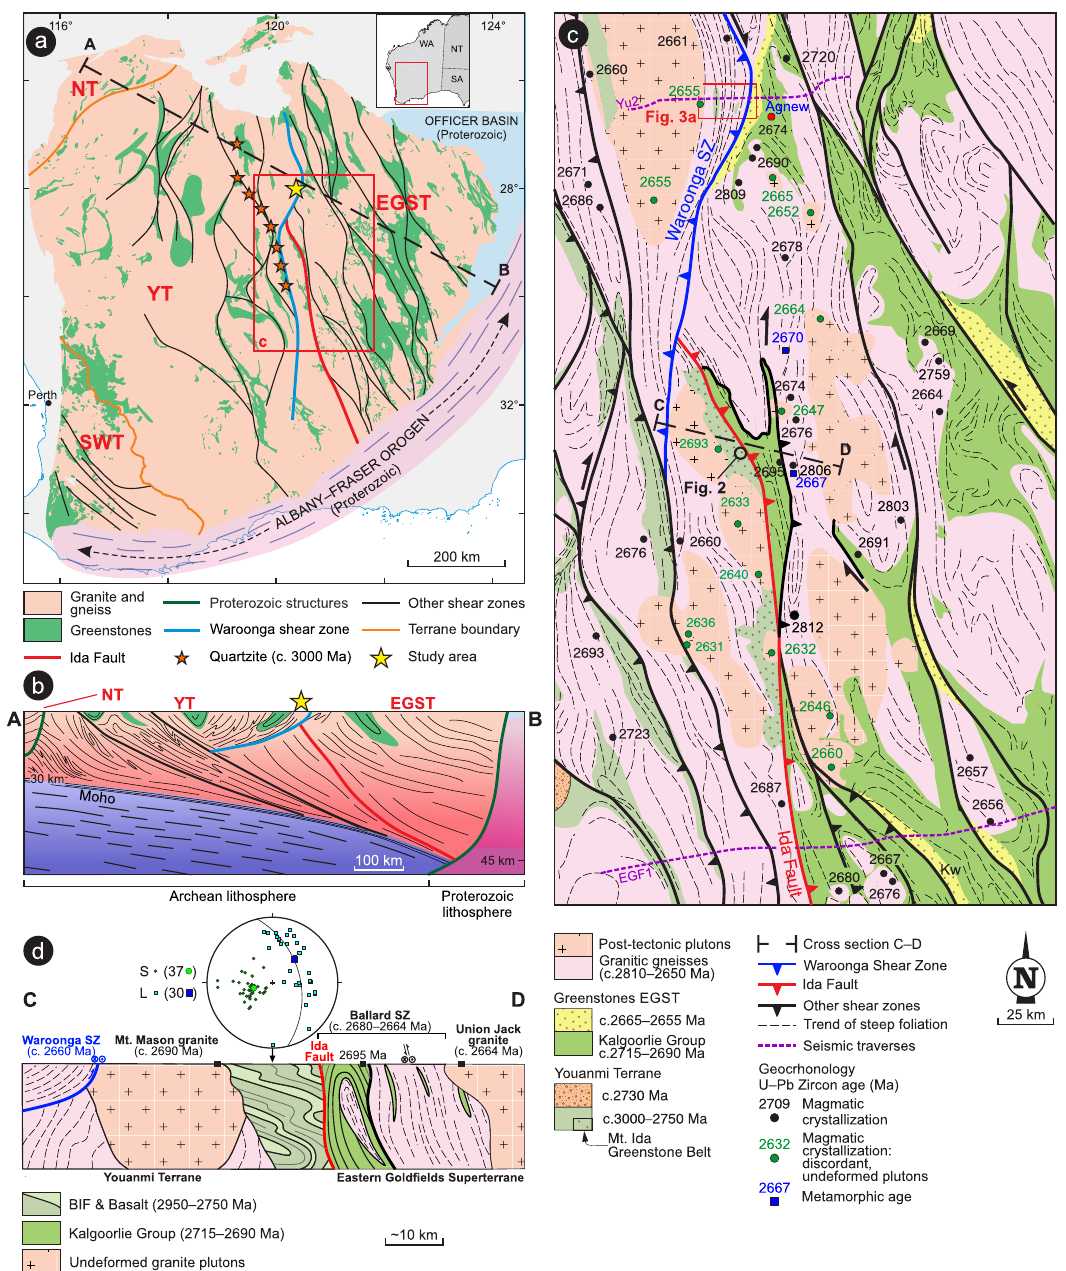
Fig. 1 | Geological maps and cross sections, Yilgarn Craton. a Simpli fi ed geolo- gical map of the Yilgarn Craton, showing the subdivision into main terranes (NT: Narryer; YT: Youanmi; SWT: Southwest; EGST: Eastern Gold fi elds Superterrane), andthenetworkofcraton-scaleshearzones.Theblackdashedlineshowsthetrace ofthecrosssectionshownin b . b Geologicalcrosssectionacrossthenorthernpart of the craton, illustrating the main crustal architecture, characterized by east- dippingMohoandlistric,crustal-scaleshearzones. c Geologicalmapofthecentral portionoftheYilgarnCraton.Note thatthe IdaFaultistruncated bytheWaroonga Shear Zone. Ages of magmatic crystallization for granite plutons are from Geoscience Australia and Geological Survey of Western Australia databases.